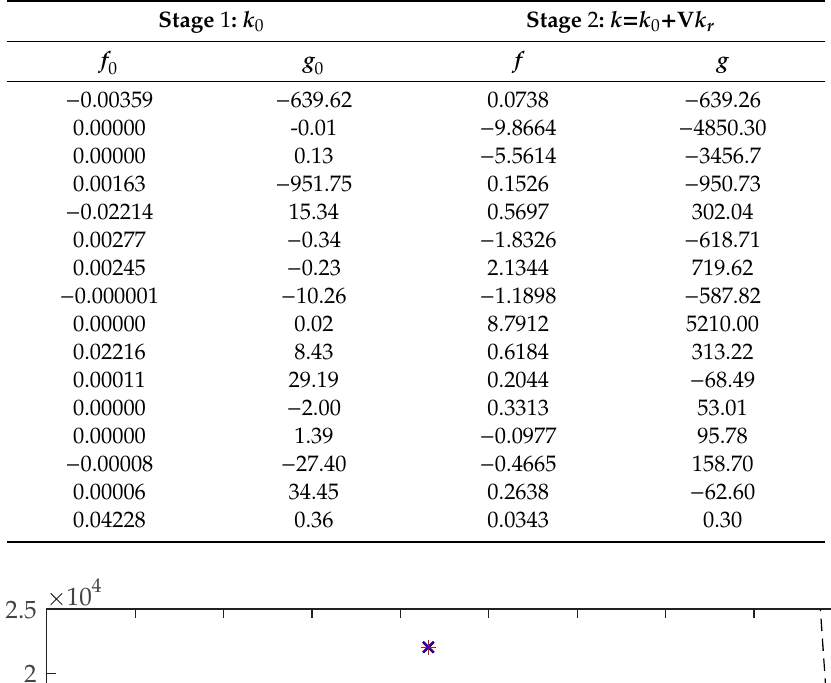
Table 10. Gains for the test-case 4.